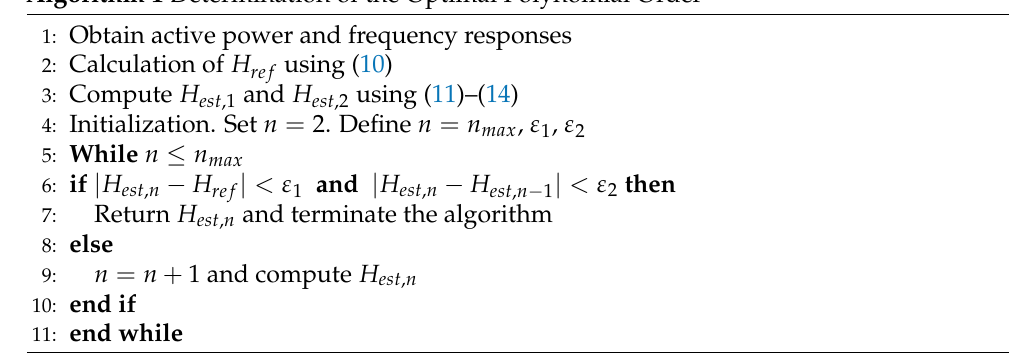
Algorithm 1 Determination of the Optimal Polynomial